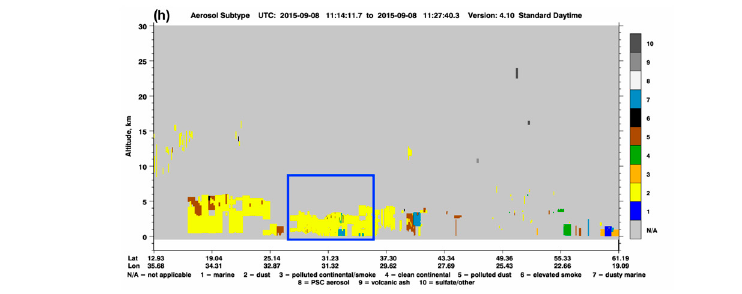
Figure 7. Back-trajectories analysis during ( a ) 8 June 2013, ( b ) 2 January 2014, ( c ) 3 March 2014, and ( d ) 9 September 2015, respectively, as well as the Cloud-Aerosol Lidar and Infrared Pathfinder Satellite Observation (CALIPSO) aerosol subtype classifications for the same scenes ( a , b , d ) with their associated highlighted region of interest: ( e ) red box: the Greater Delta and Mediterranean region (at 00:06 to 00:19 UTC 6 June 2013); ( f ) red box: the Greater Delta and Mediterranean region (at 00:05 to 00:19 UTC 2 January 2014); ( g ) red box: the Mesopotamia region (at 23:24 to 23:37 UTC 3 March 2014) and ( h ) blue box: the Egypt’s Western Desert region (at 11:14 to 11:27 UTC 9 September 2015). The missing CALIPSO aerosol subtype analysis for 3 March 2014 ( c ) due to data unavailability.